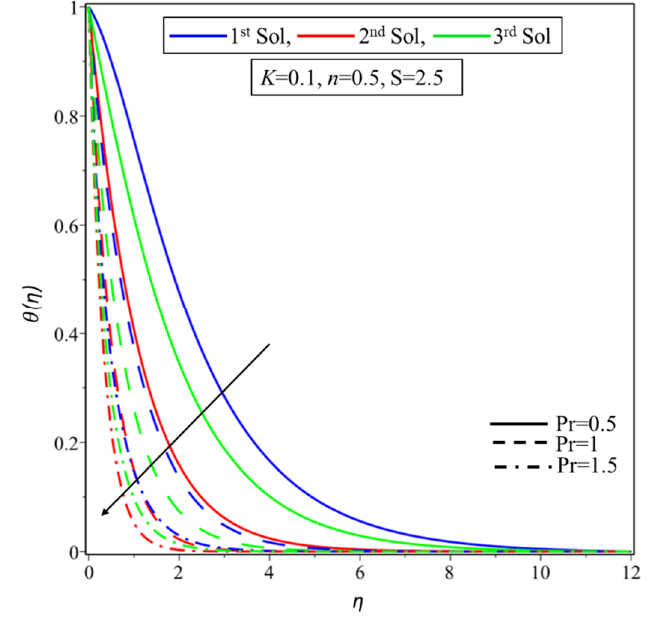
Figure 10. E ff ect of Pr on θ ( η ) Figure 10. Effect of Pr on (cid:2016)((cid:2015)) .